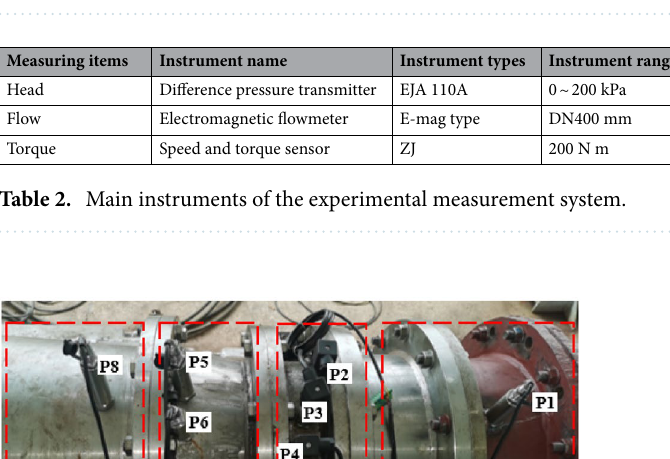
Figure 4. Schematic diagram of the experimental system.